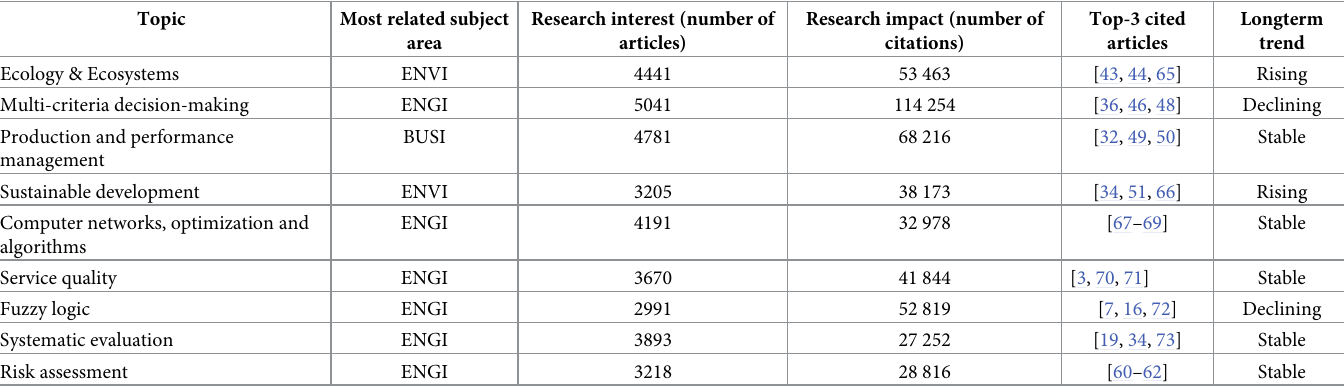
Table 2. Summary of topics